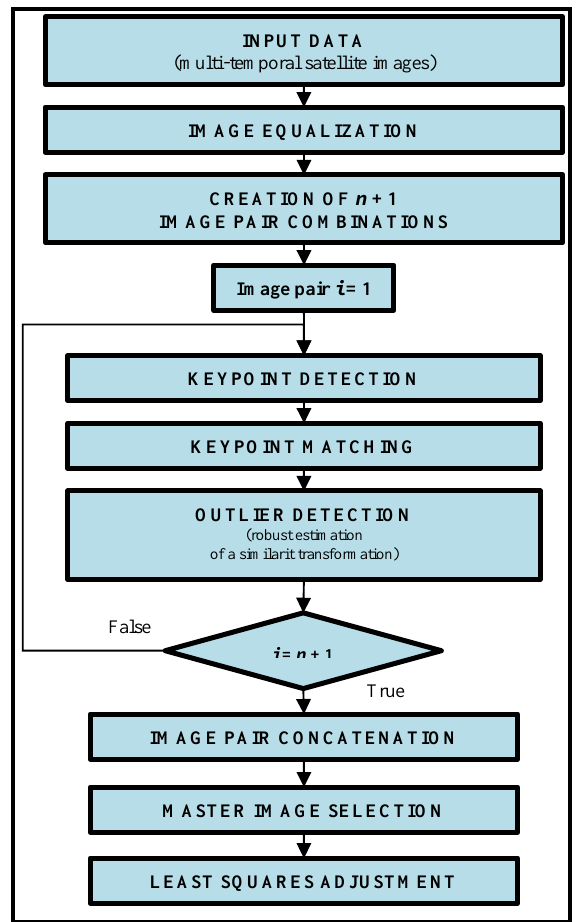
Figure 1. Flowchart of the algorithm for ‘one-to-many’ image